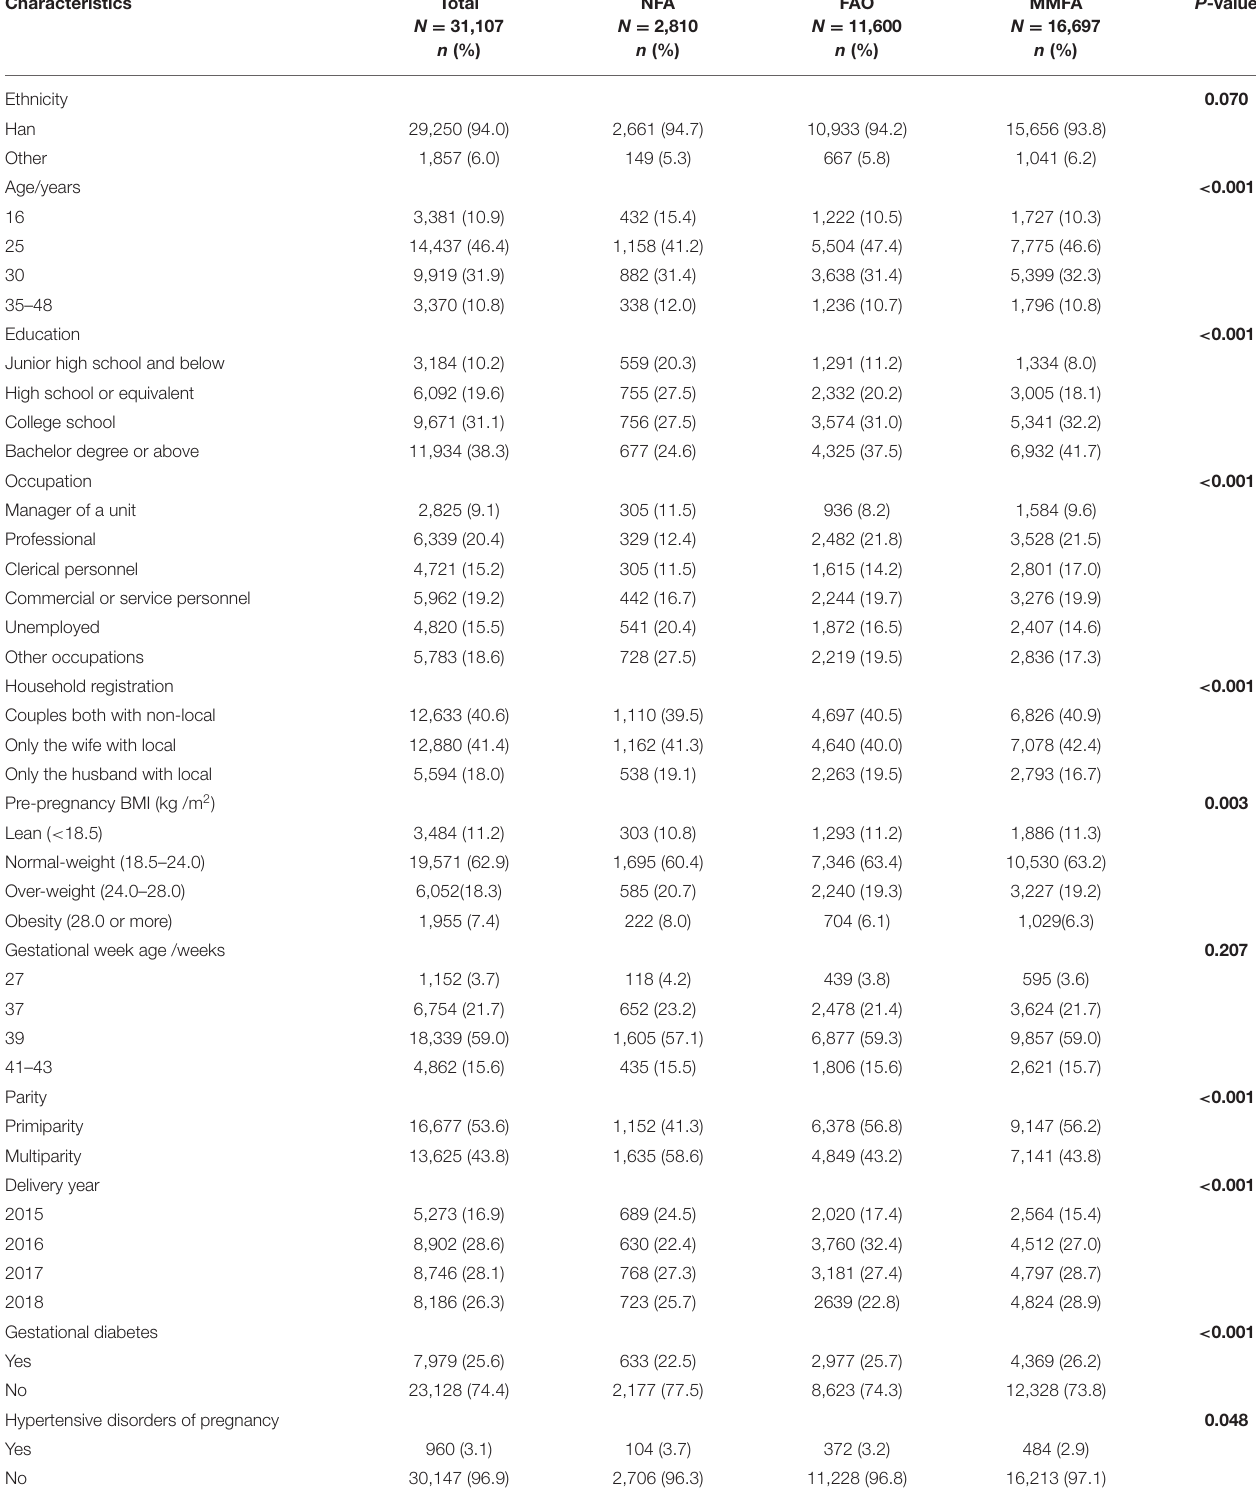
TABLE 1 | General characteristics of mothers and newborns by folic acid supplement type in singleton births at the Tongzhou Maternal and Child Health Hospital, 2015–2018 a .